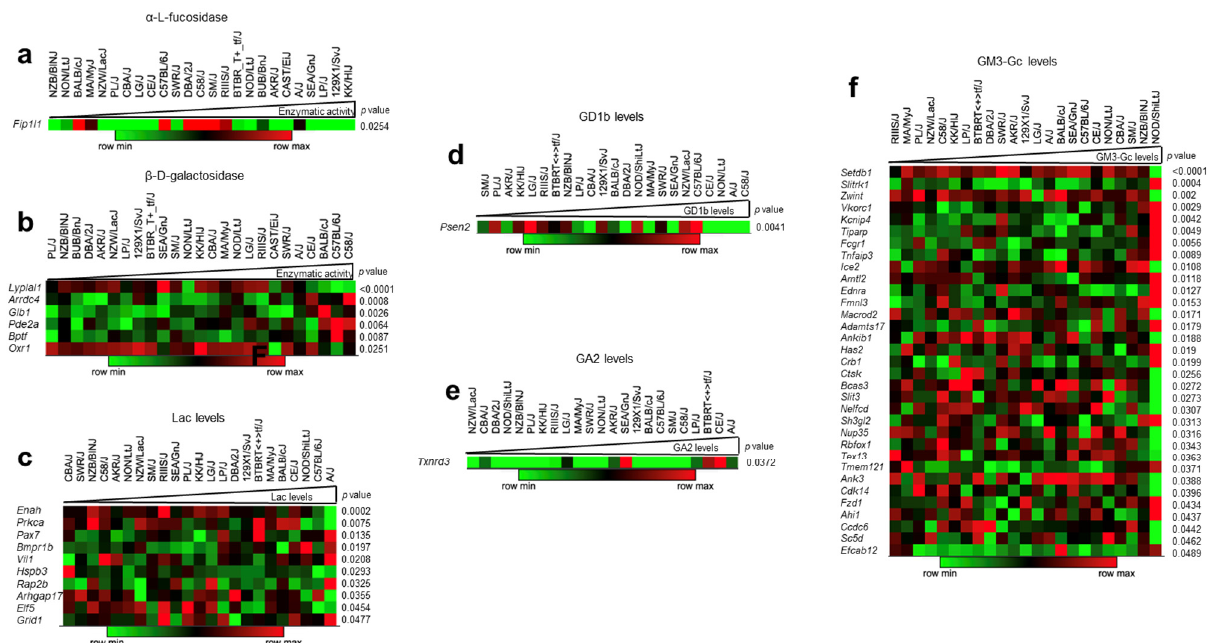
Figure 6. Correlations between the traits (enzyme activities or GSLs) and the mRNA levels of the identified modifier genes. ( a ) α -L-Fucosidase. ( b ) β -D-galactosidase. ( c ) LacCer (Lac). ( d ) GD1b. ( e ) GA2. ( f ) GM3-Gc. Only the genes with significant p values with its trait using Pearson’s correlations ( p ≤ 0.05) were plotted.